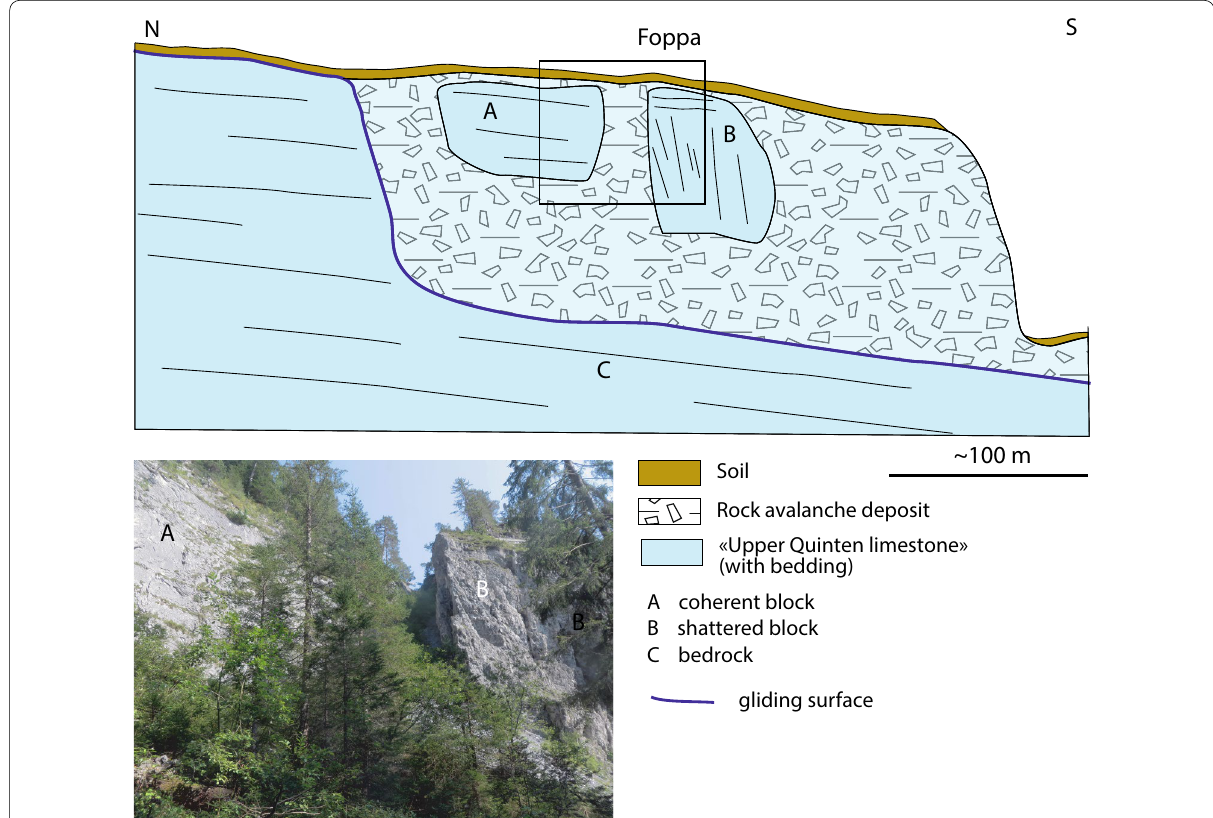
Fig. 21 Step in the glide surface west of the cable car station Foppa (coord. 2739420/1190025). The rectangle gives approximate position of photograph. Photo A.